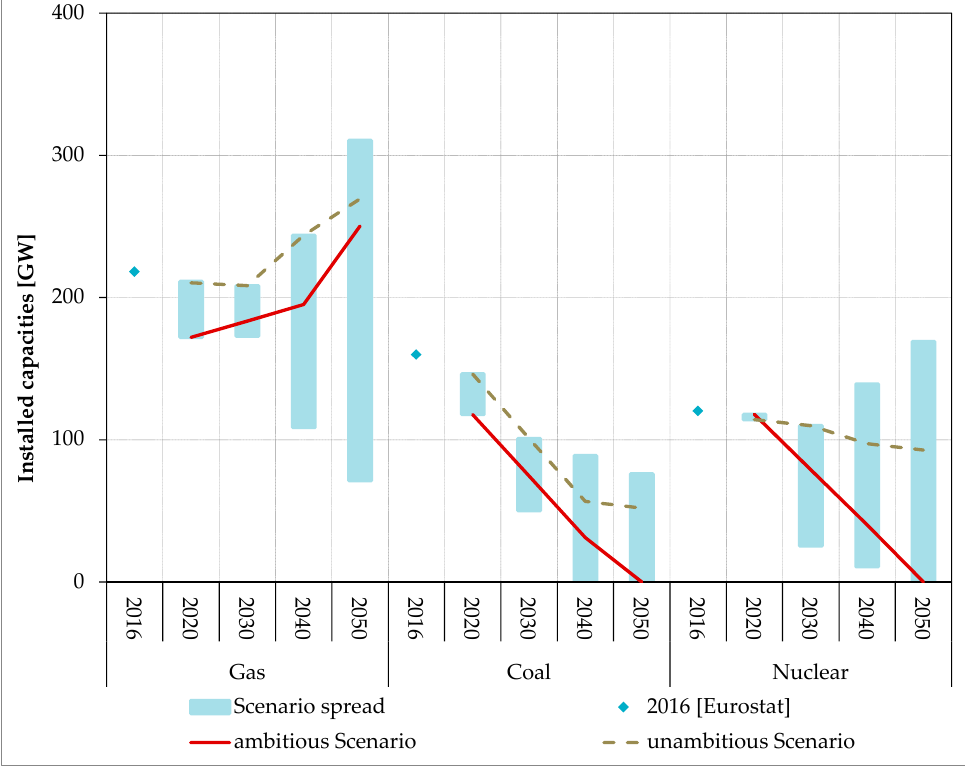
Figure 3. Comparison of conventional generation capacities installed in EU 28 countries based on References [5,29–31].